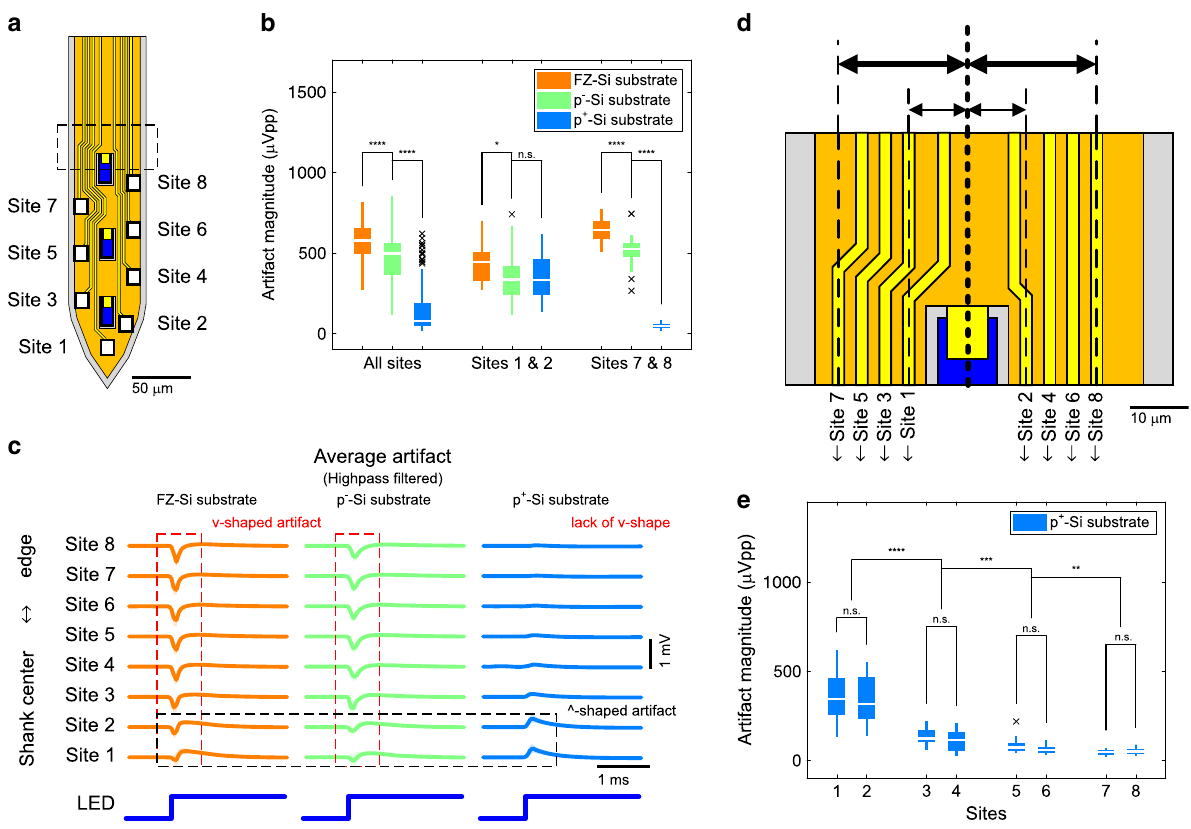
Fig. 4 Location dependence of residual artifact. a Schematic illustration of the tip of shielded μ LED optoelectrode. b The peak-to-peak magnitude of highpass fi ltered stimulation artifact recorded on shielded μ LED optoelectrodes with different substrate doping densities. Data from channels corresponding to electrodes on the shank on which an LED was turned on are plotted. LED drive signal with resulting LED surface irradiance of 75mWmm – 2 was used. Boxes indicate interquartile ranges, white lines medians, whiskers non-outlier extreme values, and black x marks outliers. c Mean waveforms of stimulation artifact recorded on the shielded μ LED optoelectrodes with different substrate doping densities, from channels that correspond to electrodes on different locations on the tips. Shaded regions show one standard deviation away from the mean. LED drive signal with resulting LED surface irradiance of 75mWmm – 2 was used. d Magni fi ed view of the region inside the rectangle with the black dashed lines on part a . The distances between the center of the interconnects and the center of an LED are shown. e Peak-to-peak magnitudes of highpass fi ltered stimulation artifact recorded from different channels on shielded μ LED optoelectrodes with heavily boron-doped silicon substrate (miniSTAR optoelectrodes). LED drive signal with resulting LED surface irradiance of 75mWmm – 2 was used. A detailed description of the samples, statistical tests used, and the results of statistical tests are provided in Supplementary Table